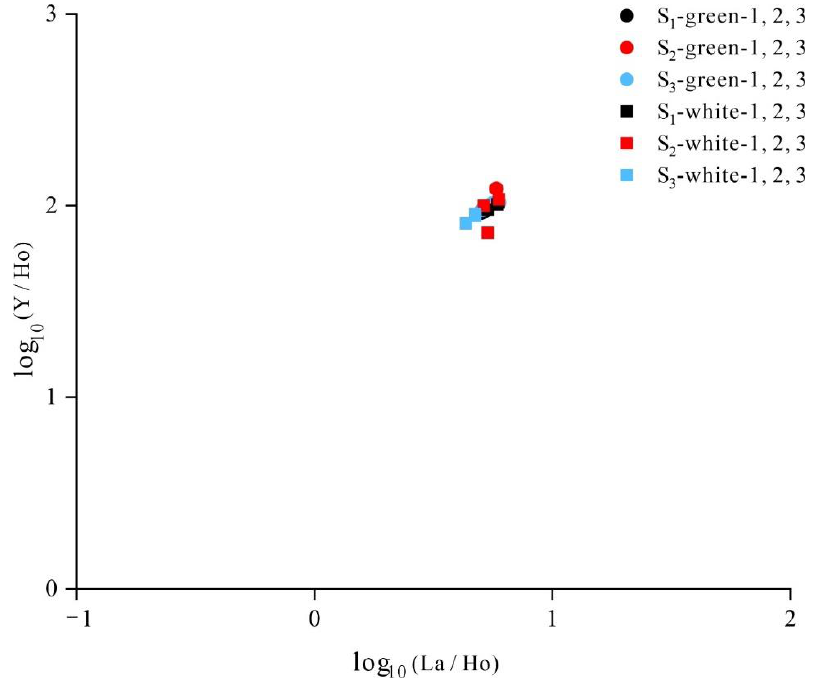
Figure 9. Y/Ho-La/Ho crossplot of three cabochon specimens of Lvwen stone. Values represent atomic ratios rather than weight ratios.